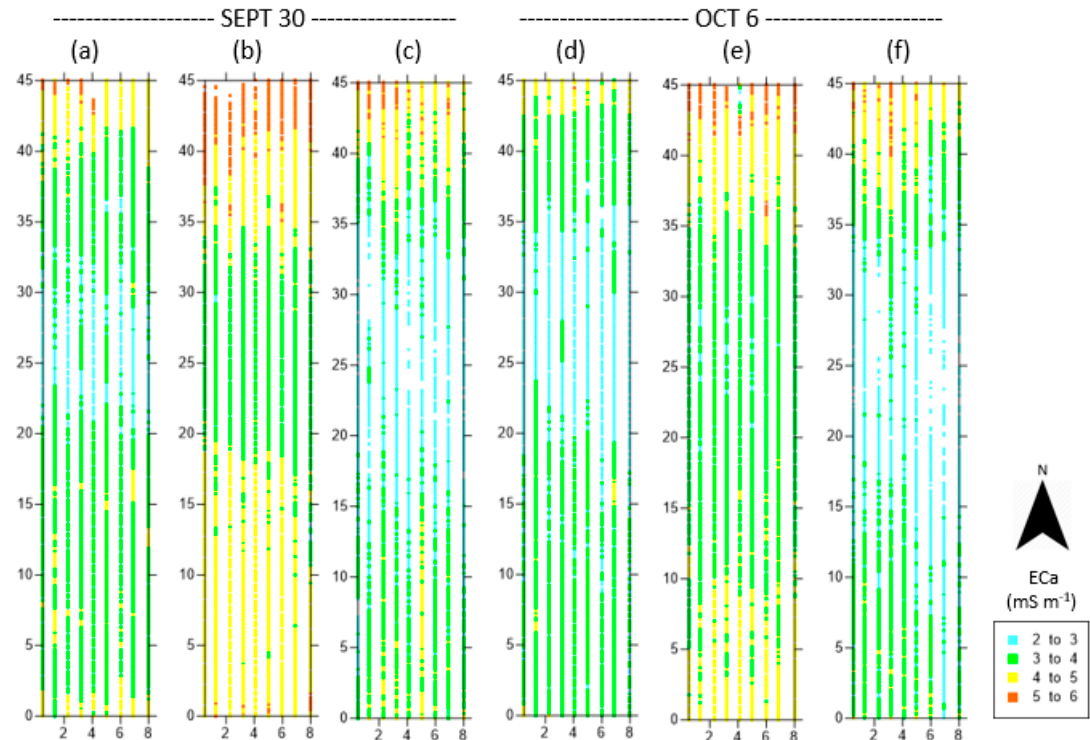
Figure 3. Results of small field EMI surveys on 30 September and 6 October 2016 for EC a - L ( a , d ), EC a - H ( b , e ) and EC a - 38 kHz ( c , f ).